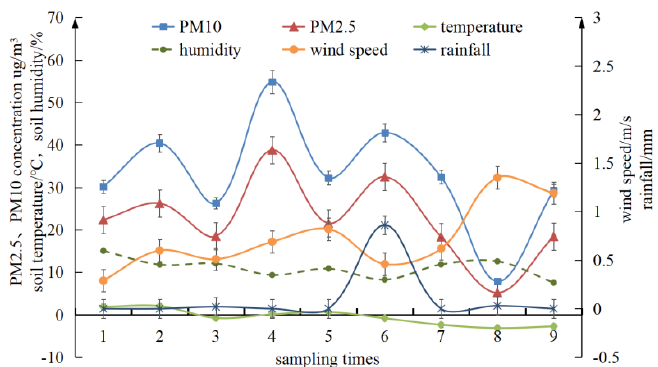
Figure 18. Huairou traditional tillage.